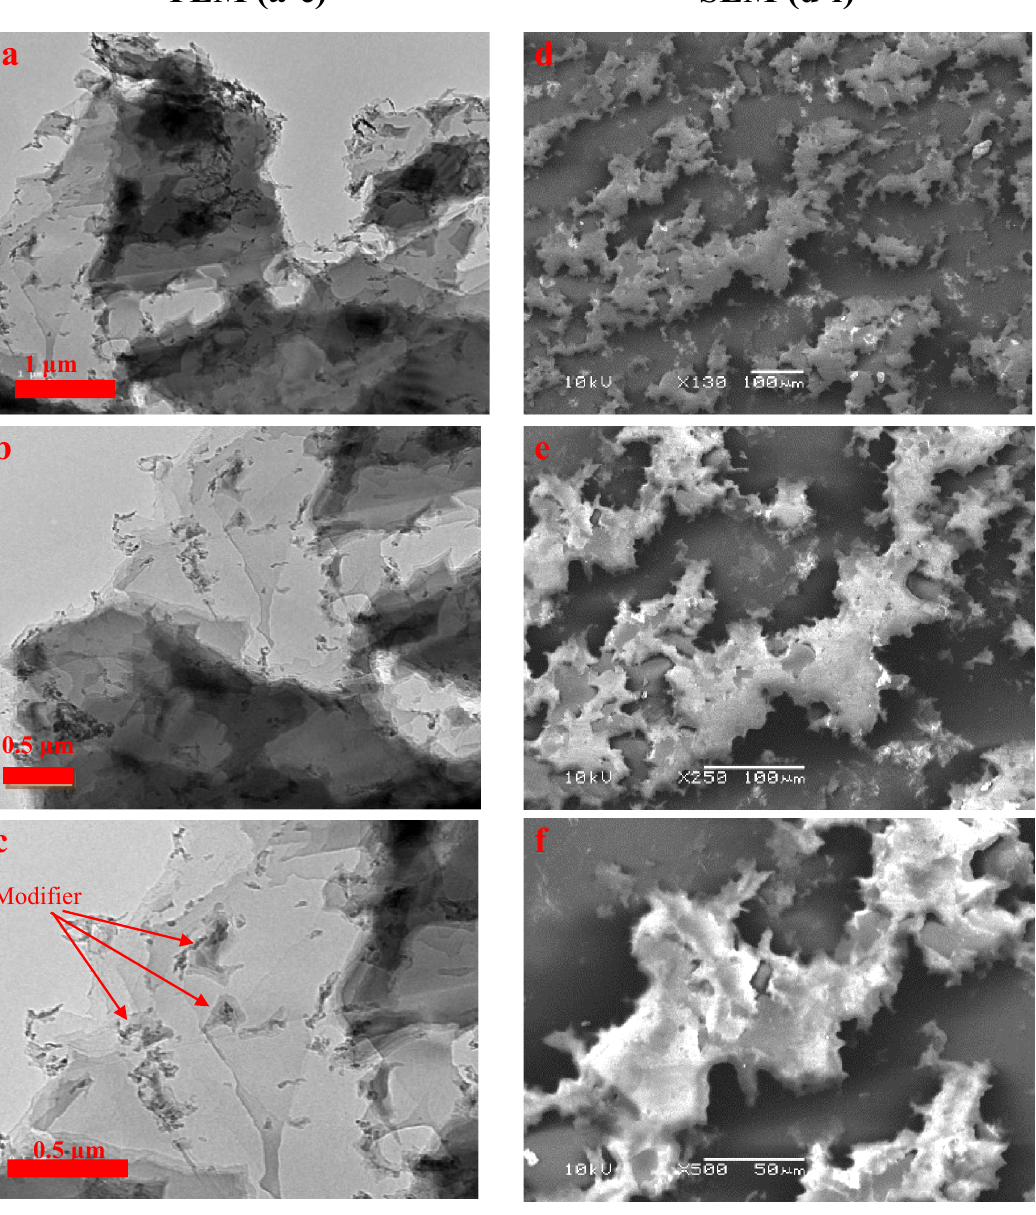
Figure 2. TEM ( a – c , left) and SEM ( d – f , right) of GO–C